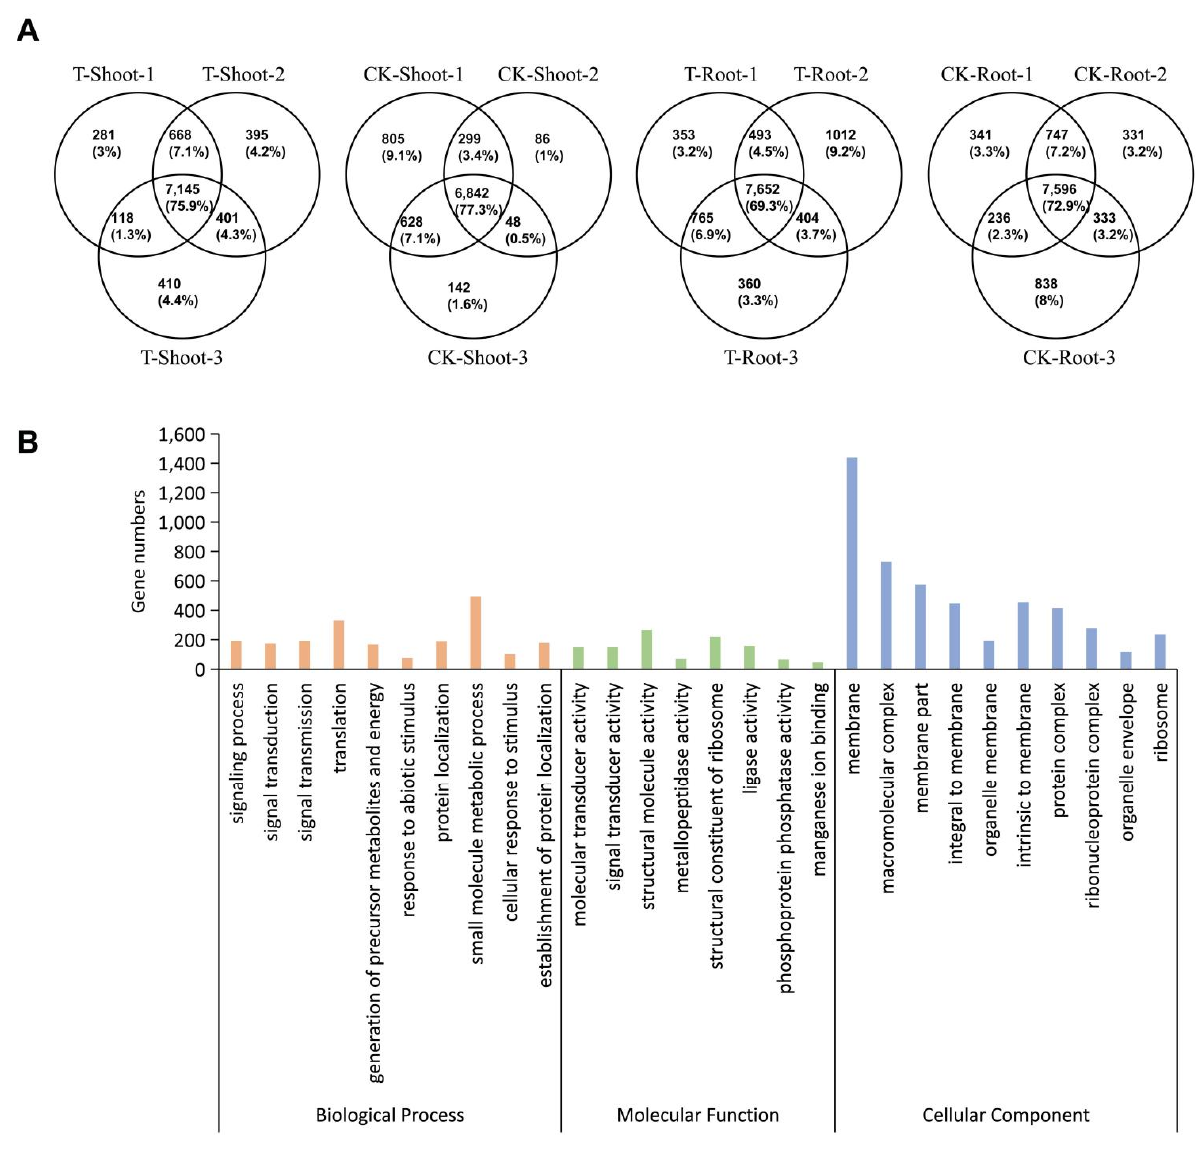
Figure 3. Transcriptome-wide m 6 A methylation profiles in rice shoots and roots under salt stress (T) and control (CK) conditions. ( A ) Venn diagrams presenting the overlap of m 6 A peaks identified in three independent m 6 A-seq experiments; ( B ) Gene Ontology (GO) analysis of the m 6 A- containing transcripts identified during the m 6 A-seq analysis. The functional characterization involved the annotation of GO terms from the biological process, molecular function, and cellular component